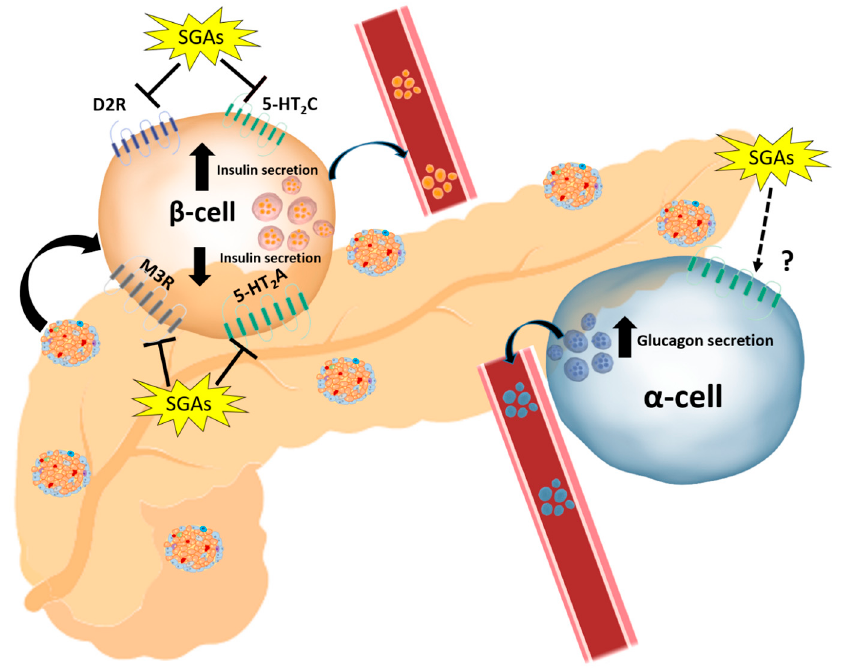
Figure 4. SGA-induced impairment in insulin secretion from β -cells and glucagon secretion from α -cells. The complexity of SGAs impact on insulin secretion is based on the effect mediated by antagonism of SGAs at different receptors. Antagonism of D2R and 5-HT 2 C stimulates insulin secretion, while antagonism of M3R and 5-HT 2 A inhibits this effect. The receptors implicated in the stimulation of glucagon secretion are still unknown.